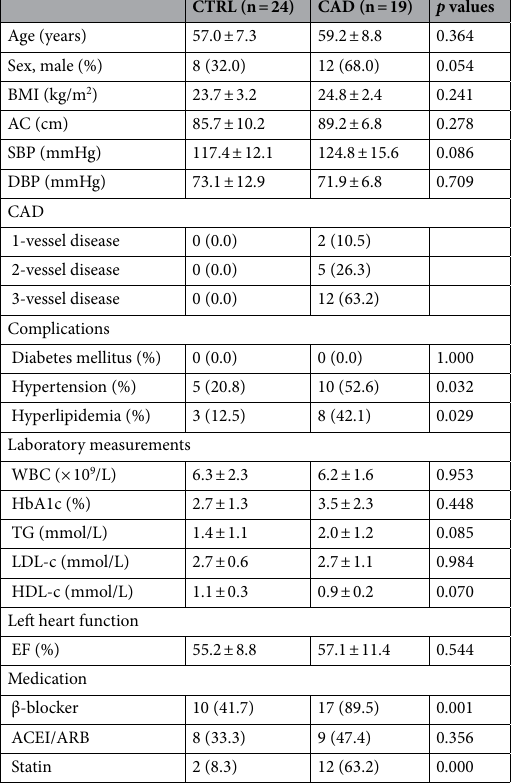
Table 1. Patients’ characteristics. Data are presented as mean ± SD or the number (%) of patients. BMI Body Mass Index, AC abdominal circumference, SBP systolic blood pressure, DBP diastolic blood pressure, WBC white blood cell, HbA1c glycated hemoglobin, TGs triglycerides, LDL-c low-density lipoprotein cholesterol, HDL-c high-density lipoprotein cholesterol, EF ejection fraction, ACEI angiotensin-converting enzyme inhibitors, ARB angiotensin receptor